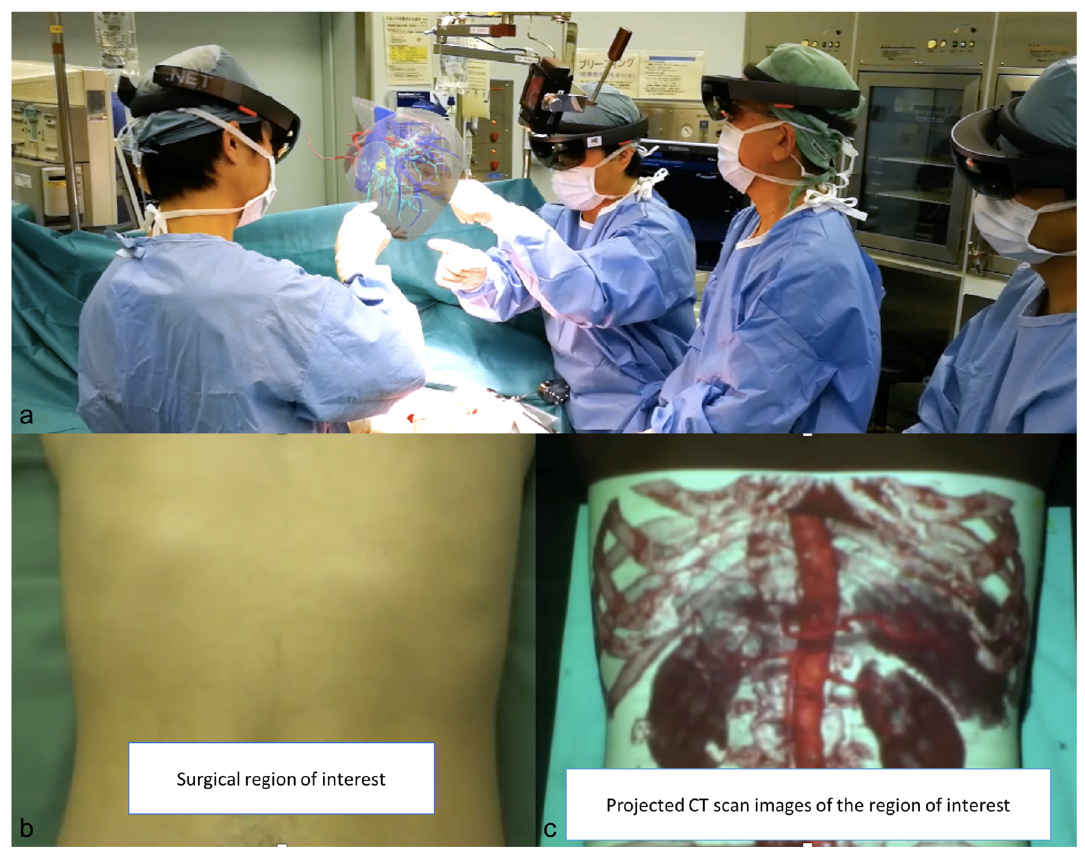
Fig. 10 Augmented reality using 3D medical images is employed for planning and guiding surgical procedures. Surgeons wear a head- mounted optical device to create augmented reality ( a ). They can